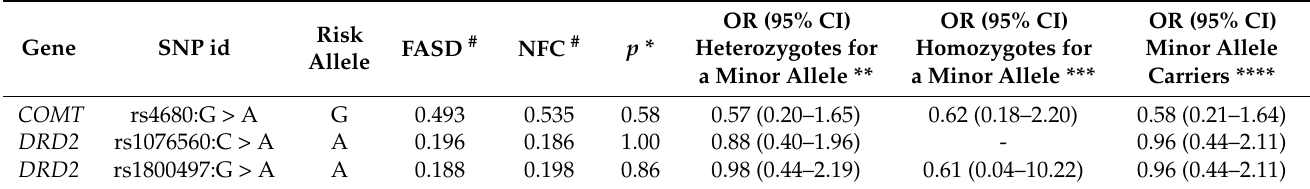
Table 5. Association analysis of COMT and DRD2 SNPs in FASD and NFC